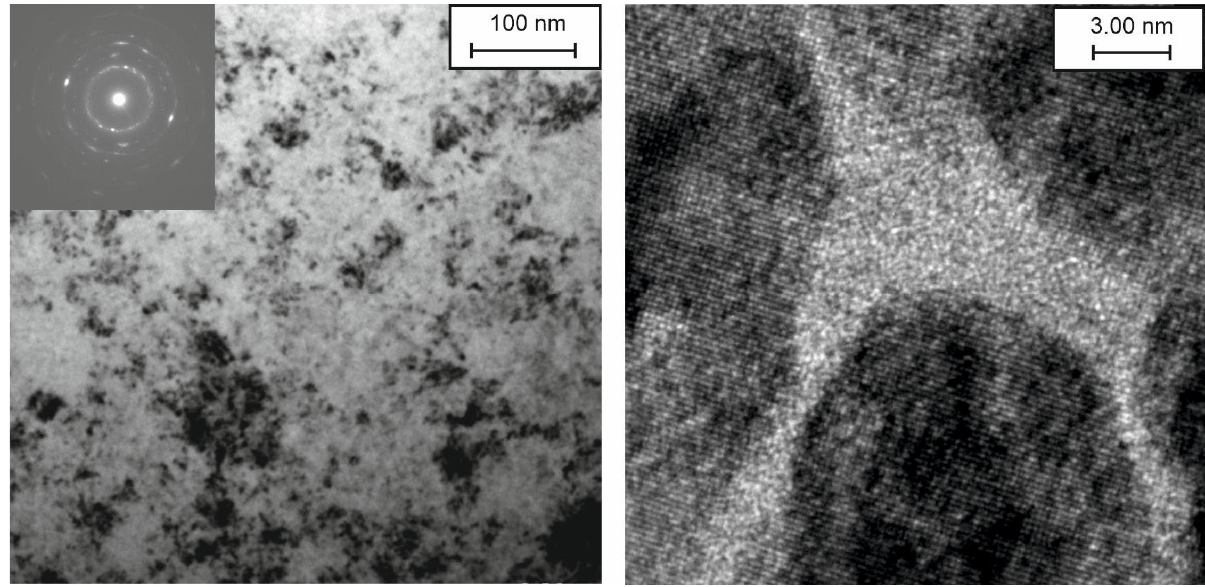
Figure 3. Transmission electron microscopy images and corresponding electron diffraction pattern of Fe 58 Co 25 Nb 3 B 13 Cu 1 alloy annealed at 750 K for 10 min. The microstructure, chemical composition of the amorphous alloys, and the heat treatment conditions of these samples have a strong influence on the crystalline phase composition and magnetic properties of nanocrystalline alloys obtained by appropriate annealing from an amorphous precursor [5]. The high-value saturation magnetic flux den- sity (B s ) and low coercive field (H c ) of soft magnetic materials are necessary for increasing the power density of modern magnetic devices. In Figure 4, hysteresis loops recorded